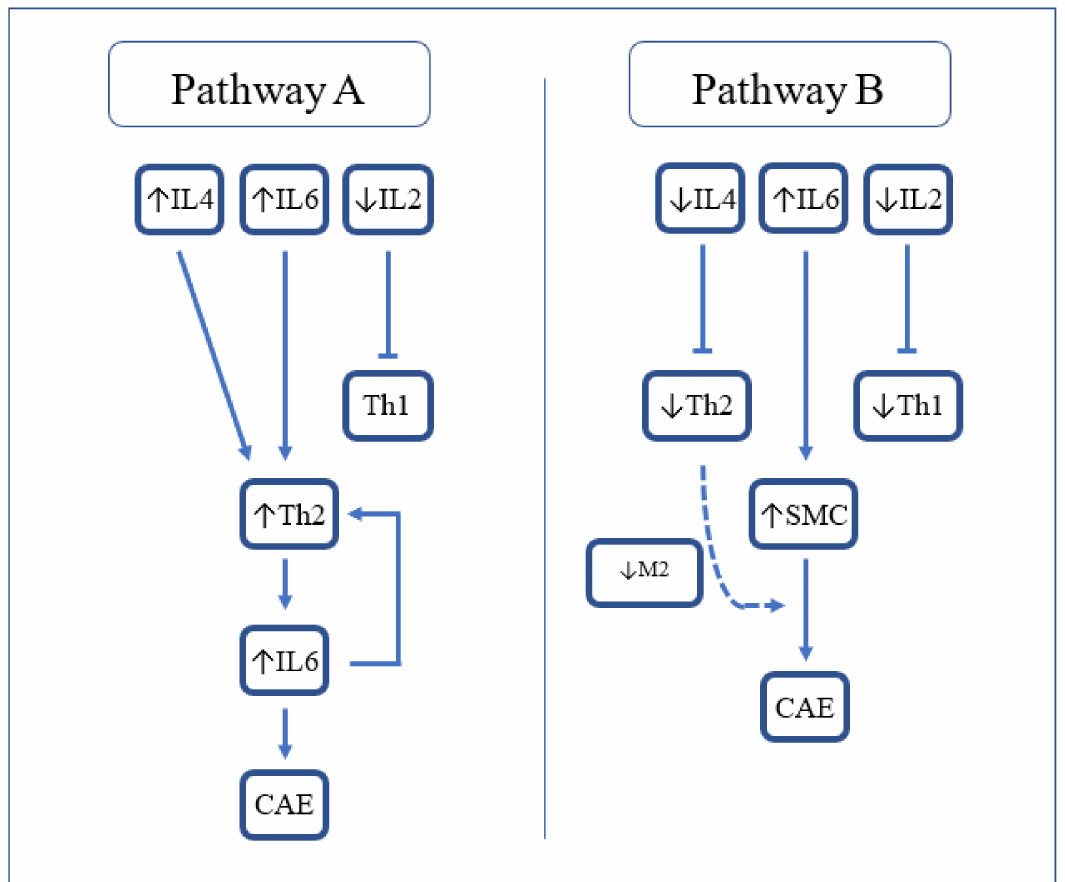
Figure 1. Proposed cytokine-mediated pathways resulting in CAE. IL-2 = Interleukin-2; IL-4 = Interleukin-4; IL-6 = Interleukin-6; Th2 = T-helper 2; CAE = coronary artery ectasia; SMC = smooth muscle cells; and M2 = M2